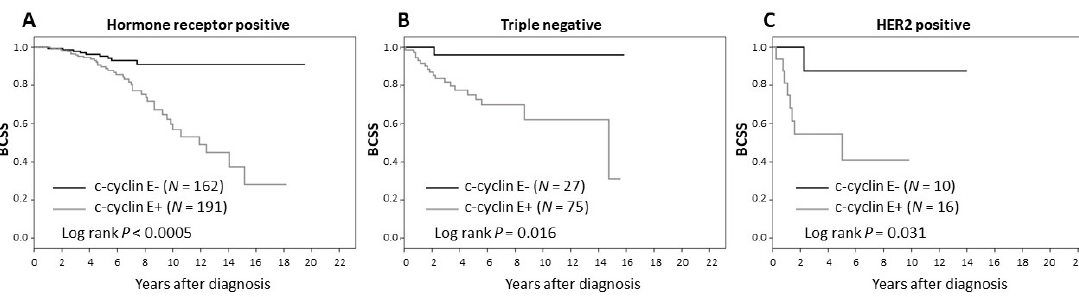
Figure 4. Breast cancer-specific survival by subtype: ( A ) hormone receptor (ER and/or PR) positive, ( B ) triple negative, ( C ) HER2 positive.